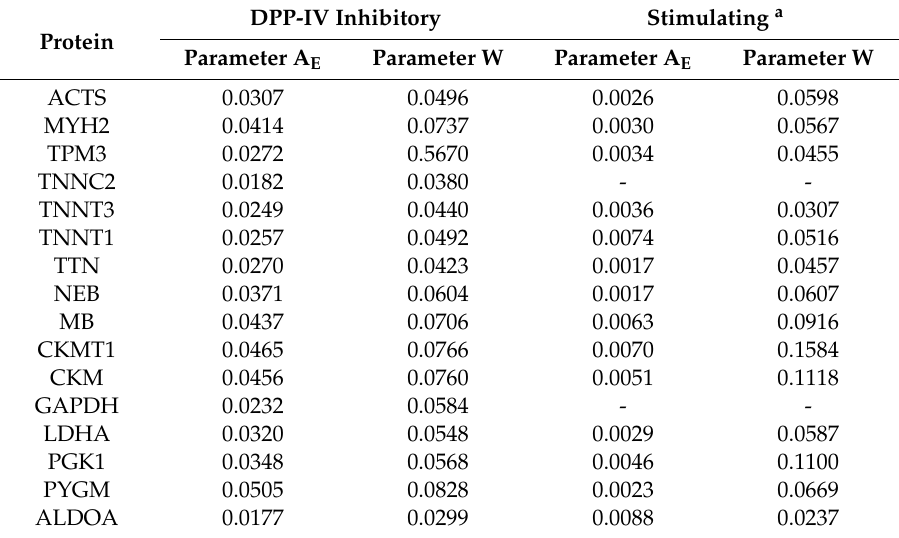
Table 3. Frequency of the release of fragments with a given activity by selected enzymes (parameter A E ) and the relative frequency of release of fragments with given activity by selected enzymes (parameter W) from porcine proteins after in silico